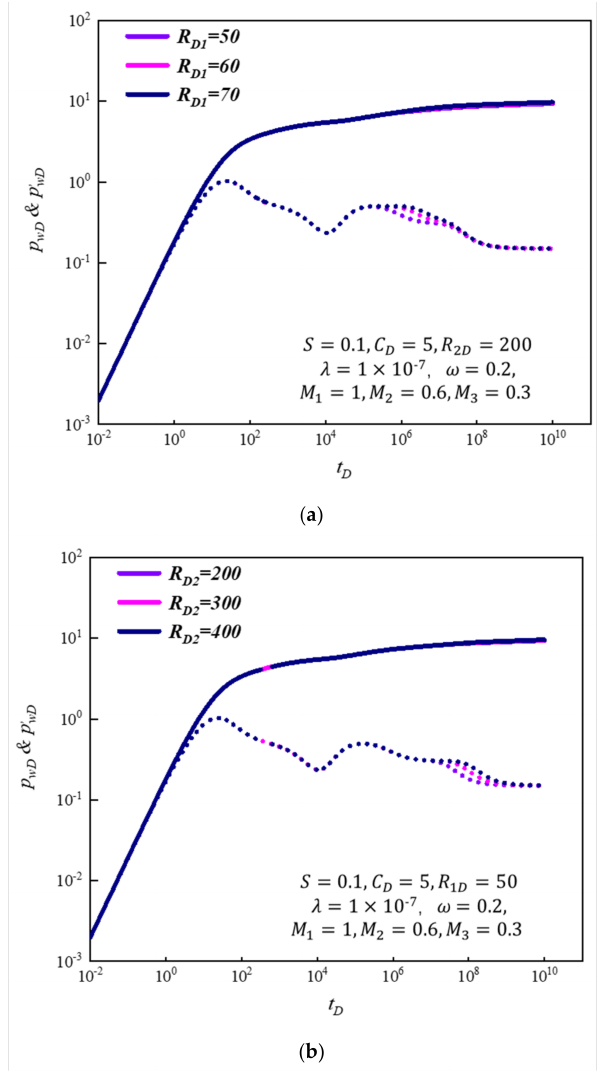
Figure 5. The comparison of type curves under a different composite radius R Di : ( a ) zone I; ( b ) zone